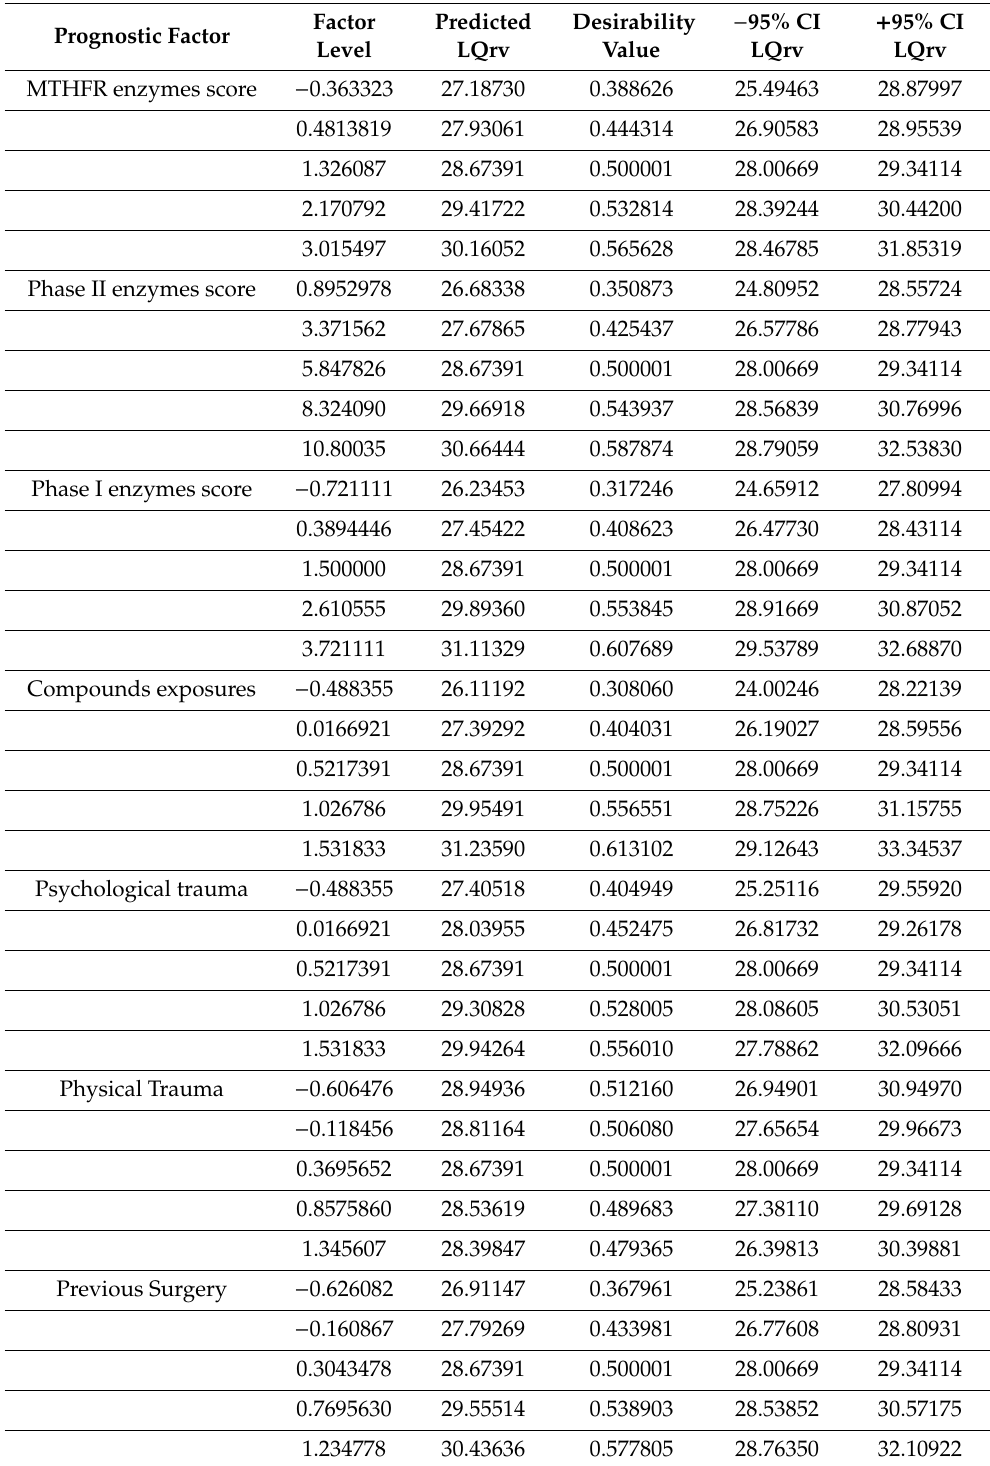
Table 4. Partial desirability model of main factors predicting olfactory-related quality of life in MCS